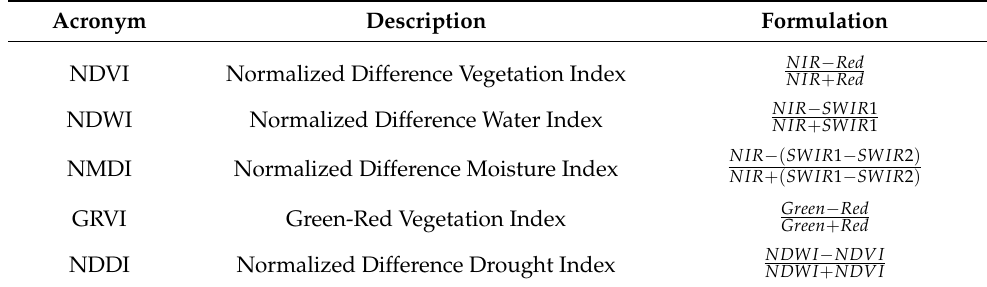
Table 2. Spectral indices used for downscaling of Landsat 8 land surface temperature